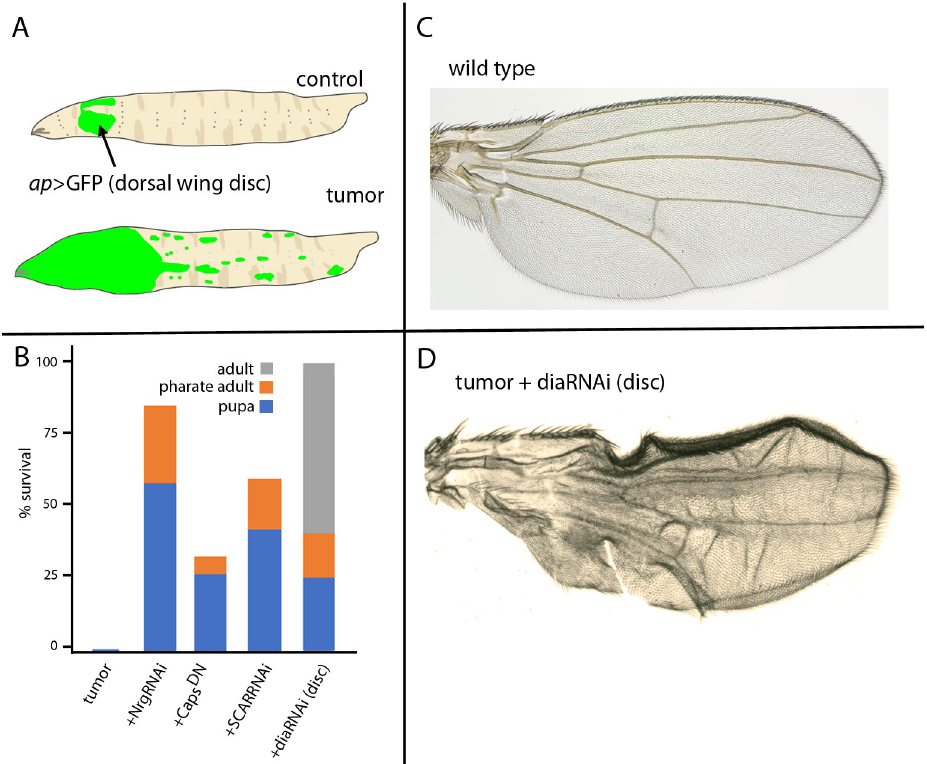
Fig 4. Conditions that ablate cytonemes promote survival. (A) Cartoon of a wild type larva depicting cells expressing GFP in the imaginal disc dorsal compartments ( ap- Gal4; green, arrow) and of EGFR-Pcn tumor larva with overgrowth and metastasis throughout the larva (green). (B) Survival of EGFR-Pcn tumor, tumor + diaRNAi, NrgRNAi, SCARRNAi and Caps DN larvae to pupal (blue), pharate adult (orange) and adult stage (gray). Student’s t test P values: (between P < 0.05 and P > 1.10 − 8 ) with n = 15–30 larvae for each genotype. (C) Control adult wing. (D) EGFR-Pcn + diaRNAi wing, genotype: ap-Gal4 , UAS-psq RNAi /UAS-CD8 : GFP;UAS-EGFR , tub-Gal80 ts /UAS-dia RNAi .